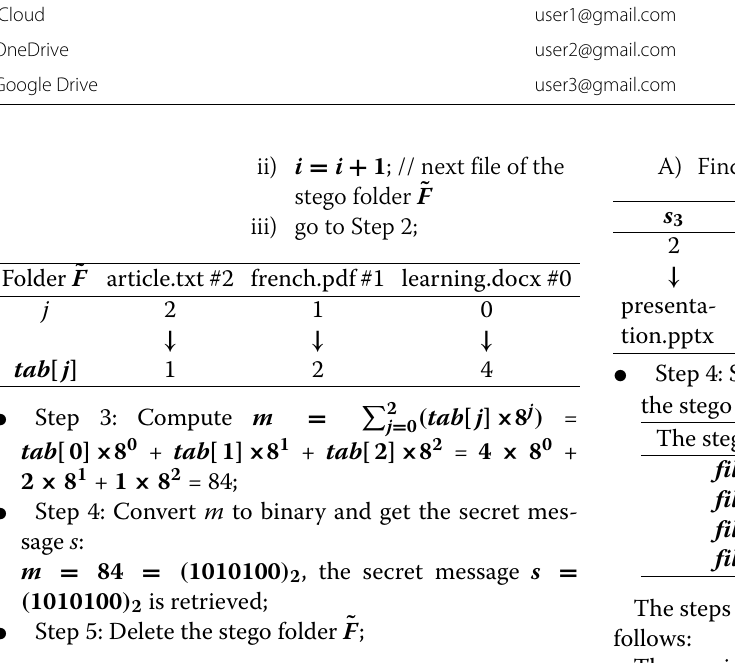
Table 2 The set of 3 cloud service providers handled and their credentials Cloud Name